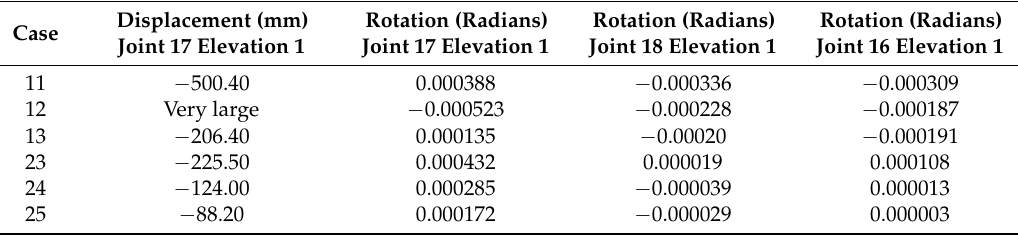
Figure 15. Displacement at notionally removed column D3 (part of grid line D) when moment frames are located at perimeters and along grid lines B, C, D, E, F and G (non-linear dynamic analysis case 22). Table 10. Comparison between displacements and rotations when edge column D1 is